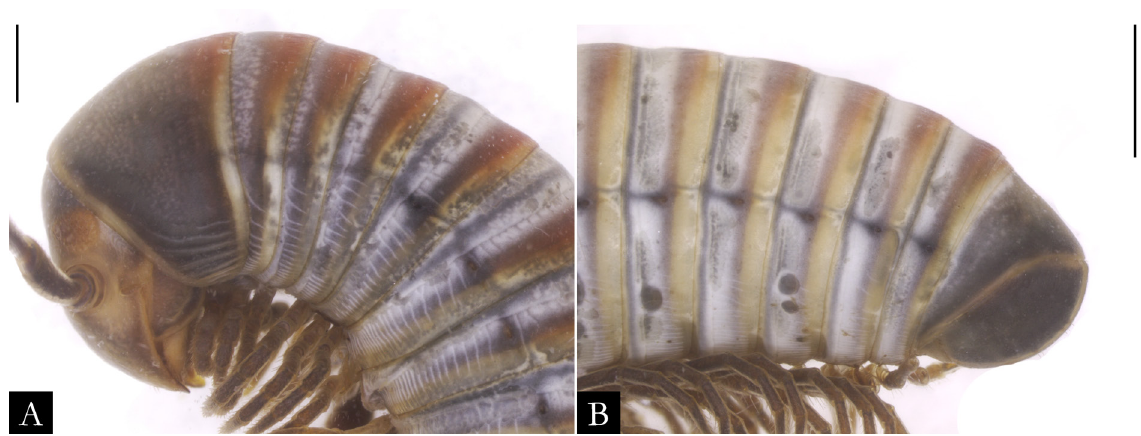
Fig. 87. Pseudonannolene magna Udulutsch & Pietrobon, 2003, paratype, ♂ (MZSP 941), in lateral view. A . Anterior region. B . Posterior region. Scale bars = 1